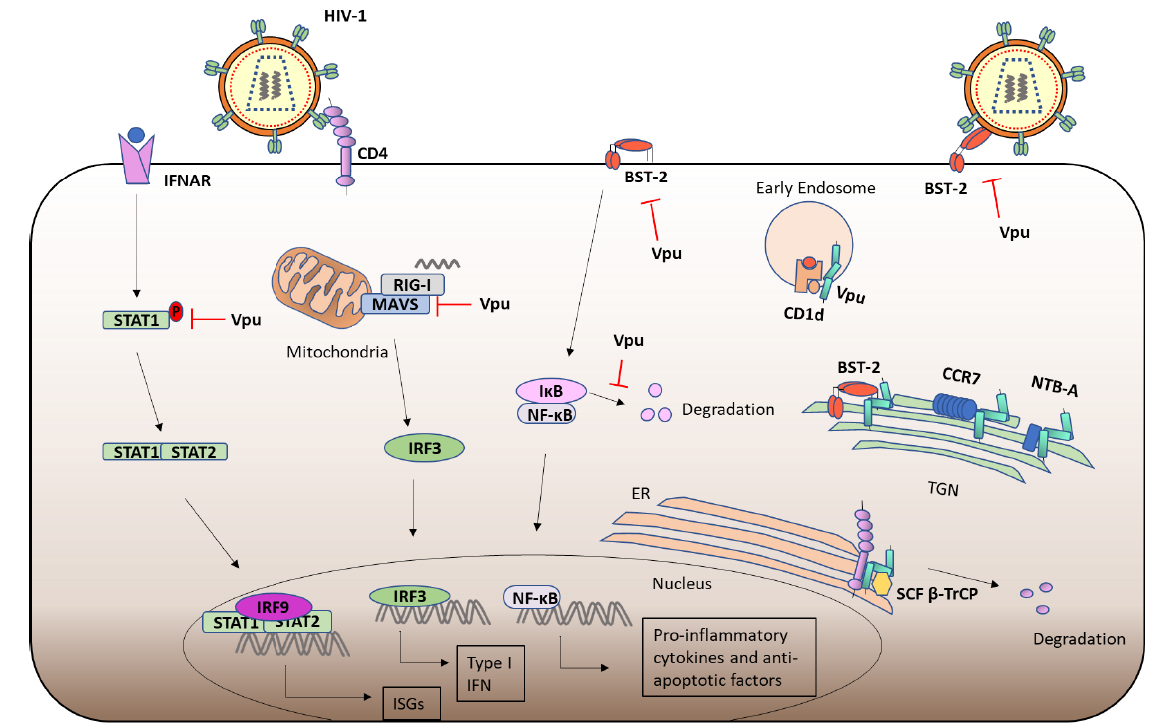
Figure 3. HIV-1 Vpu mediated immune evasion. Vpu downregulates the cell surface expression of various receptors, in- cluding the HIV-1 target receptor CD4, to evade immune responses and promote viral egress. Vpu sequesters CD4 in